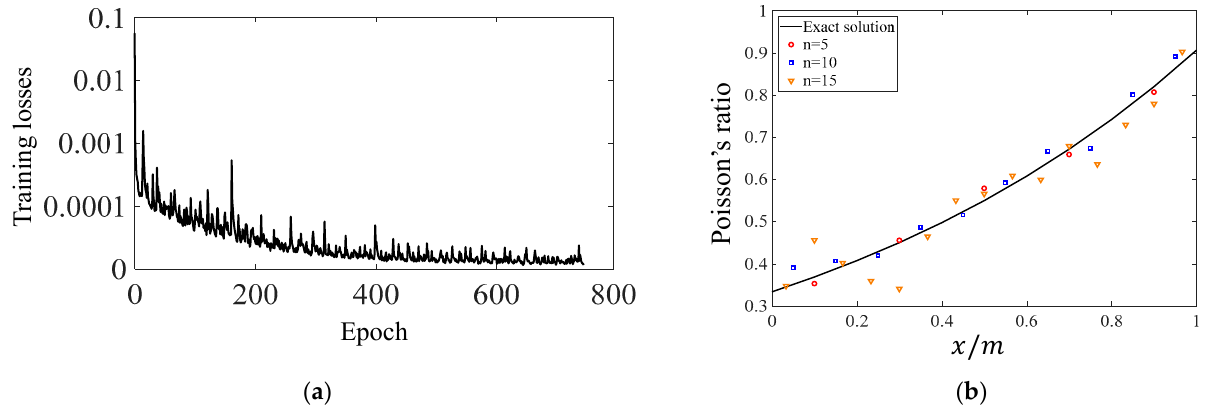
Figure 11. ( a ) Training loss versus epoch ( n = 10); ( b ) Converged v n ( n = 5, 10, and 15) obtained from the PINN in the 𝑥 direction.